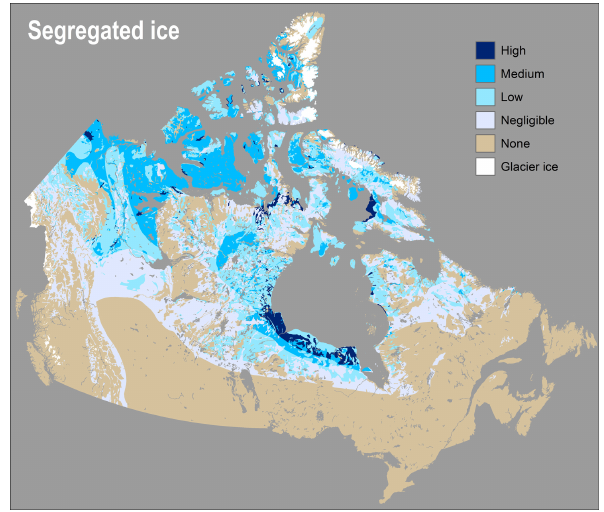
Figure 3. Modelled segregated ice abundance.